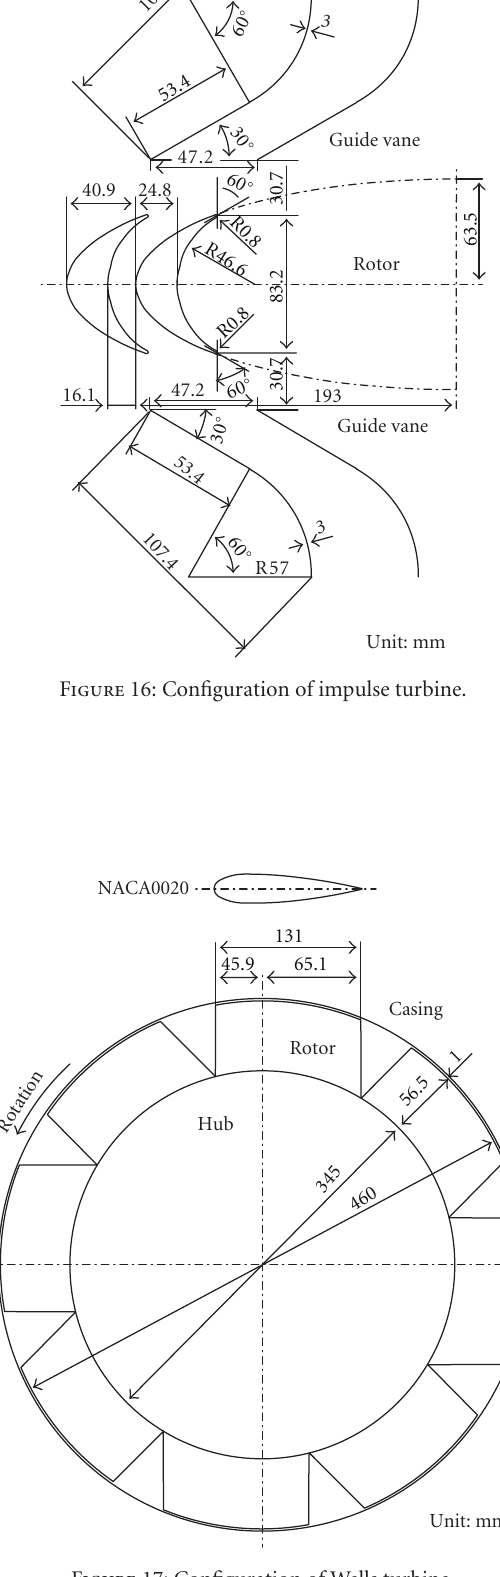
Figure 17: Configuration of Wells turbine.